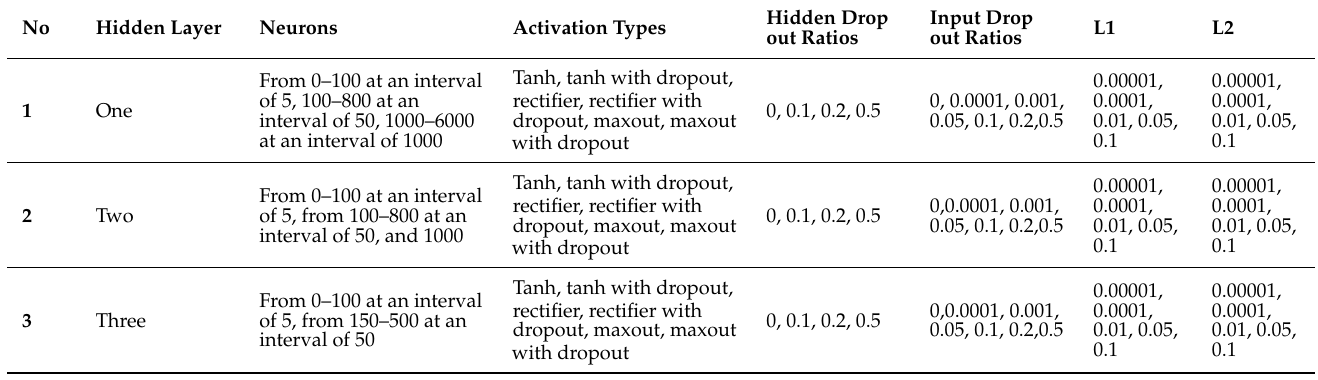
Table A1. Table showing hyperparameters tuned with their range of respective values applied in the study for deep learning models.